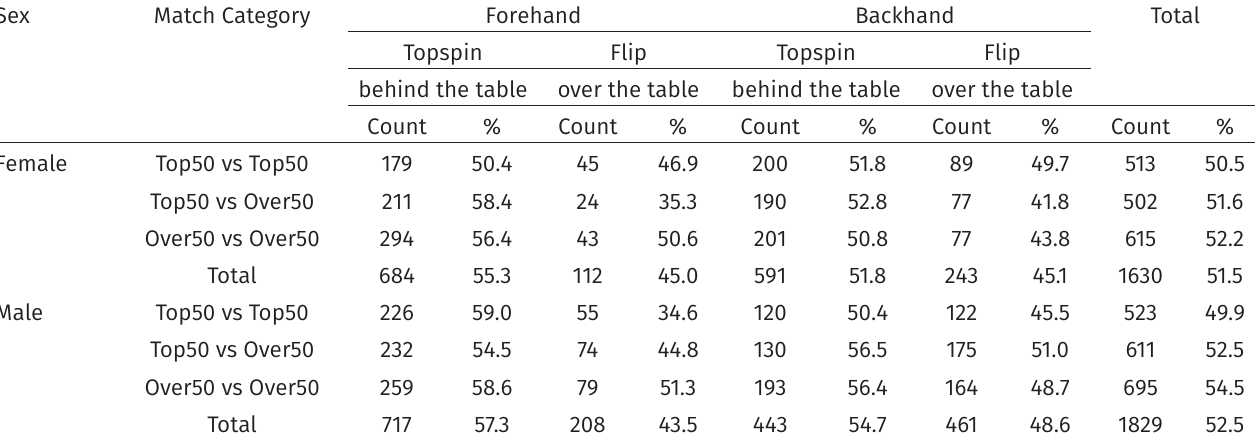
Table 3. Incidences of won rallies and winning probabilities (in %) for the FOS player for the “typical FOSs” in the two-factor factorial model.